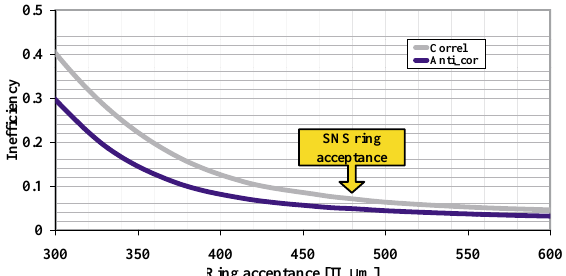
FIG. 10. (Color) Integrated profile of the residual halo after traversing the collimation system. For a ring acceptance of 480 p mm mrad, the inefficiency is about 5% for the correlated case and 7% for the anticorrelated.